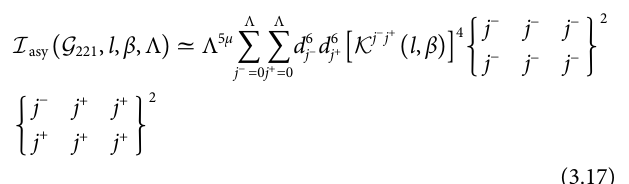
TABLE 6 | Numerical values of the divergence ’ s degree for the 4-point amplitude I Duflo